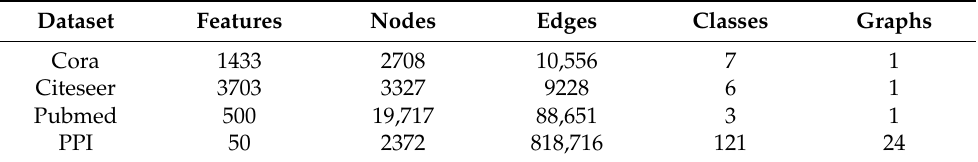
Table 1. Datasets